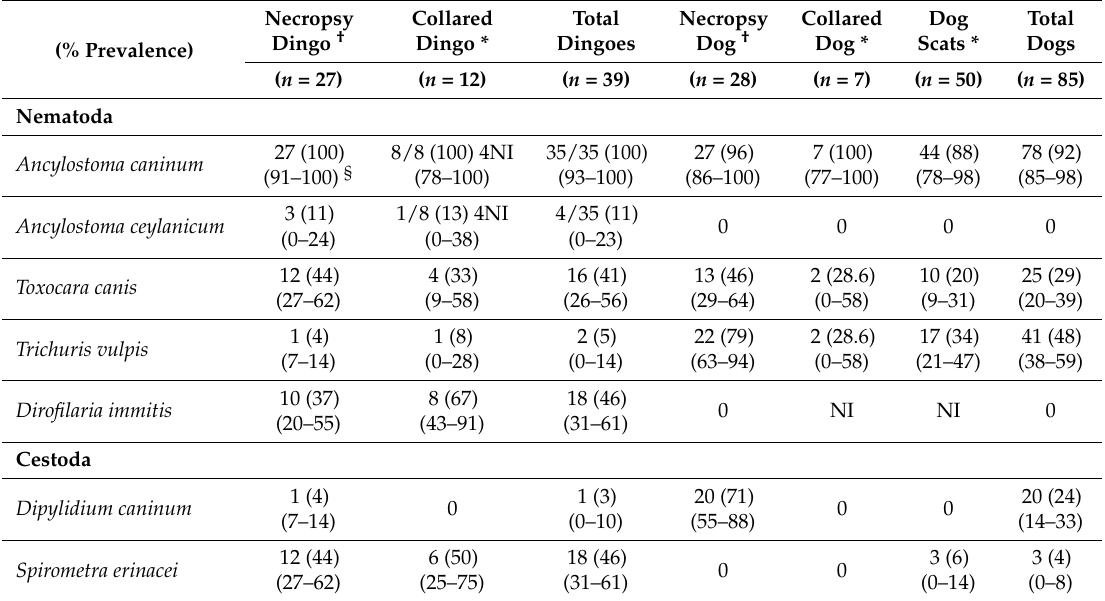
Table 1. Number of infected and prevalence of helminth infections in free-roaming domestic dogs and